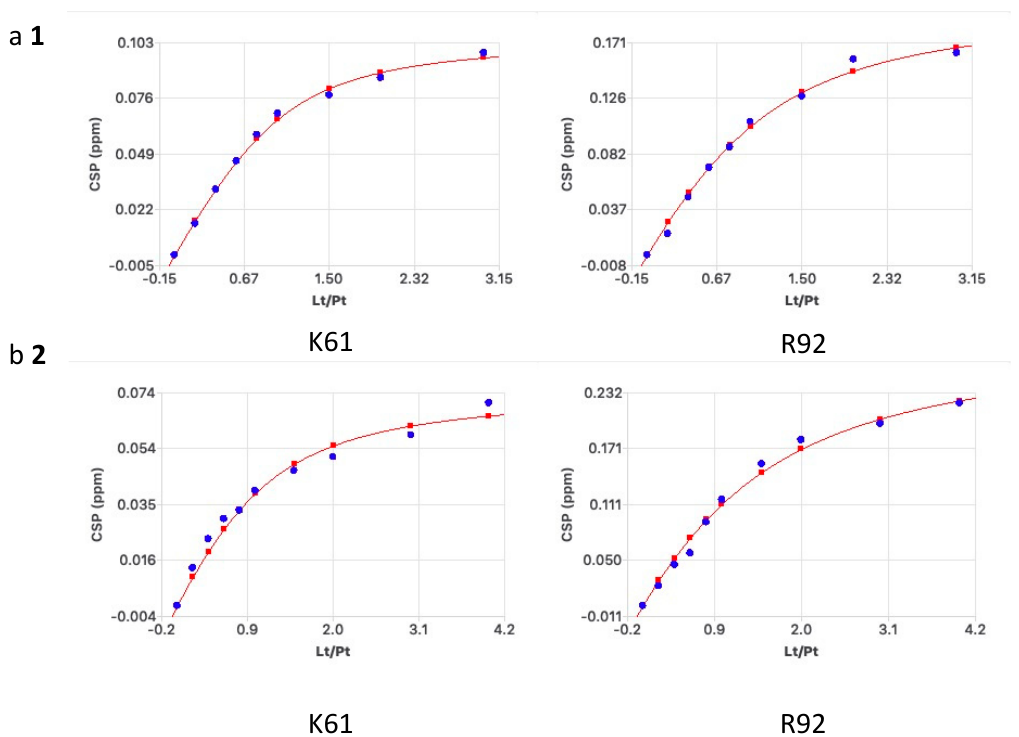
Figure 5. Normalized CSP changes used for calculating the binding curves for K61 and R92 for ( a ) 1 and ( b ) 2 , respectively. K D was calculated assuming a 1:1 complex. Table 1. K D and σ K D of K61 and R92.